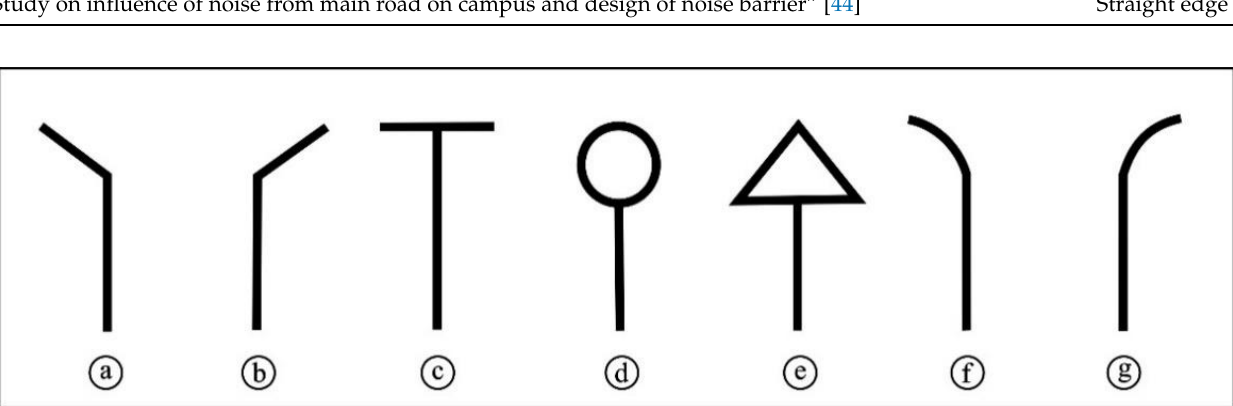
Figure 3. Geometries of different noise barriers. ( a ) L-shape (left); ( b ) L-shape (right); ( c ) T-shape; ( d ) cylindrical; ( e ) roof edge; ( f ) curved cantilever (left); ( g ) curved cantilever (right).